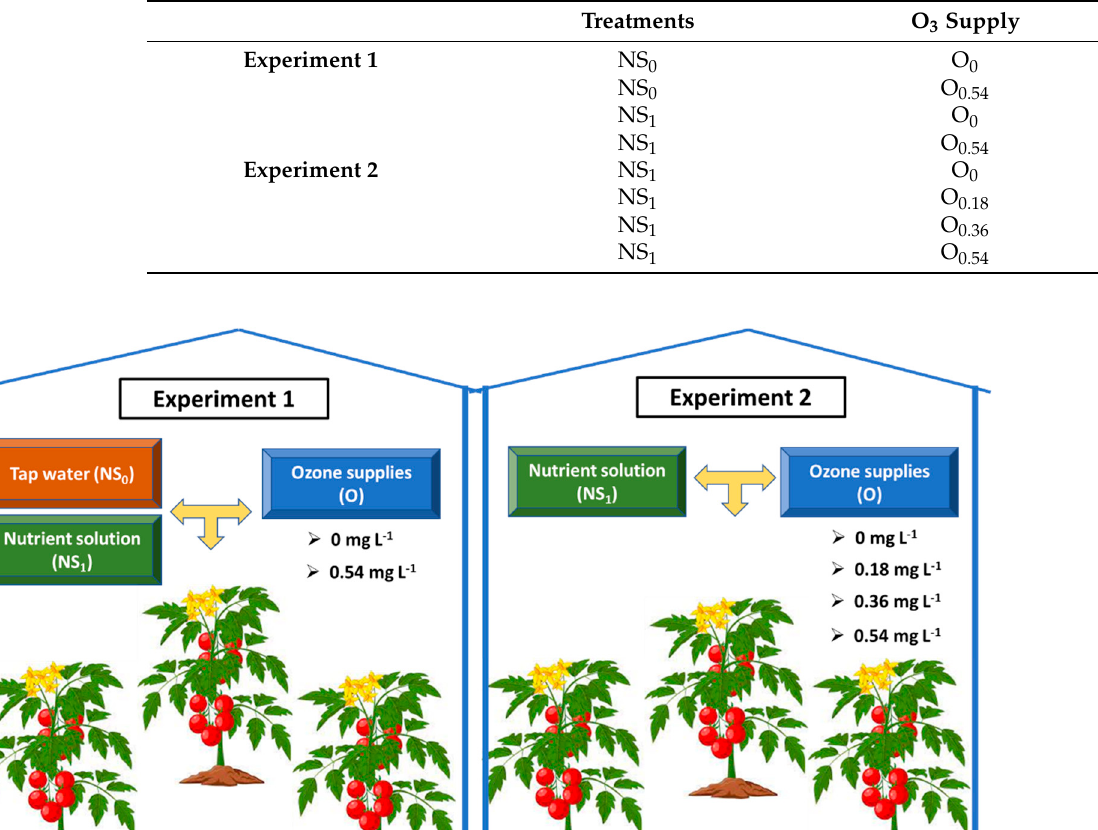
Table 1. Description of the different treatments performed in each experiment. (NS 0 ) tap water, (NS 1 ) treatment supplying fertigation with the nutrient solution (NS) and O 0 ; O 0.18 ; O 0.36 ; O 0.54 : fertigation with ozone supplies with the nutrient solution at different levels: 0, 0.18, 0.36 and 0.54 mg L − 1 ; respectively.